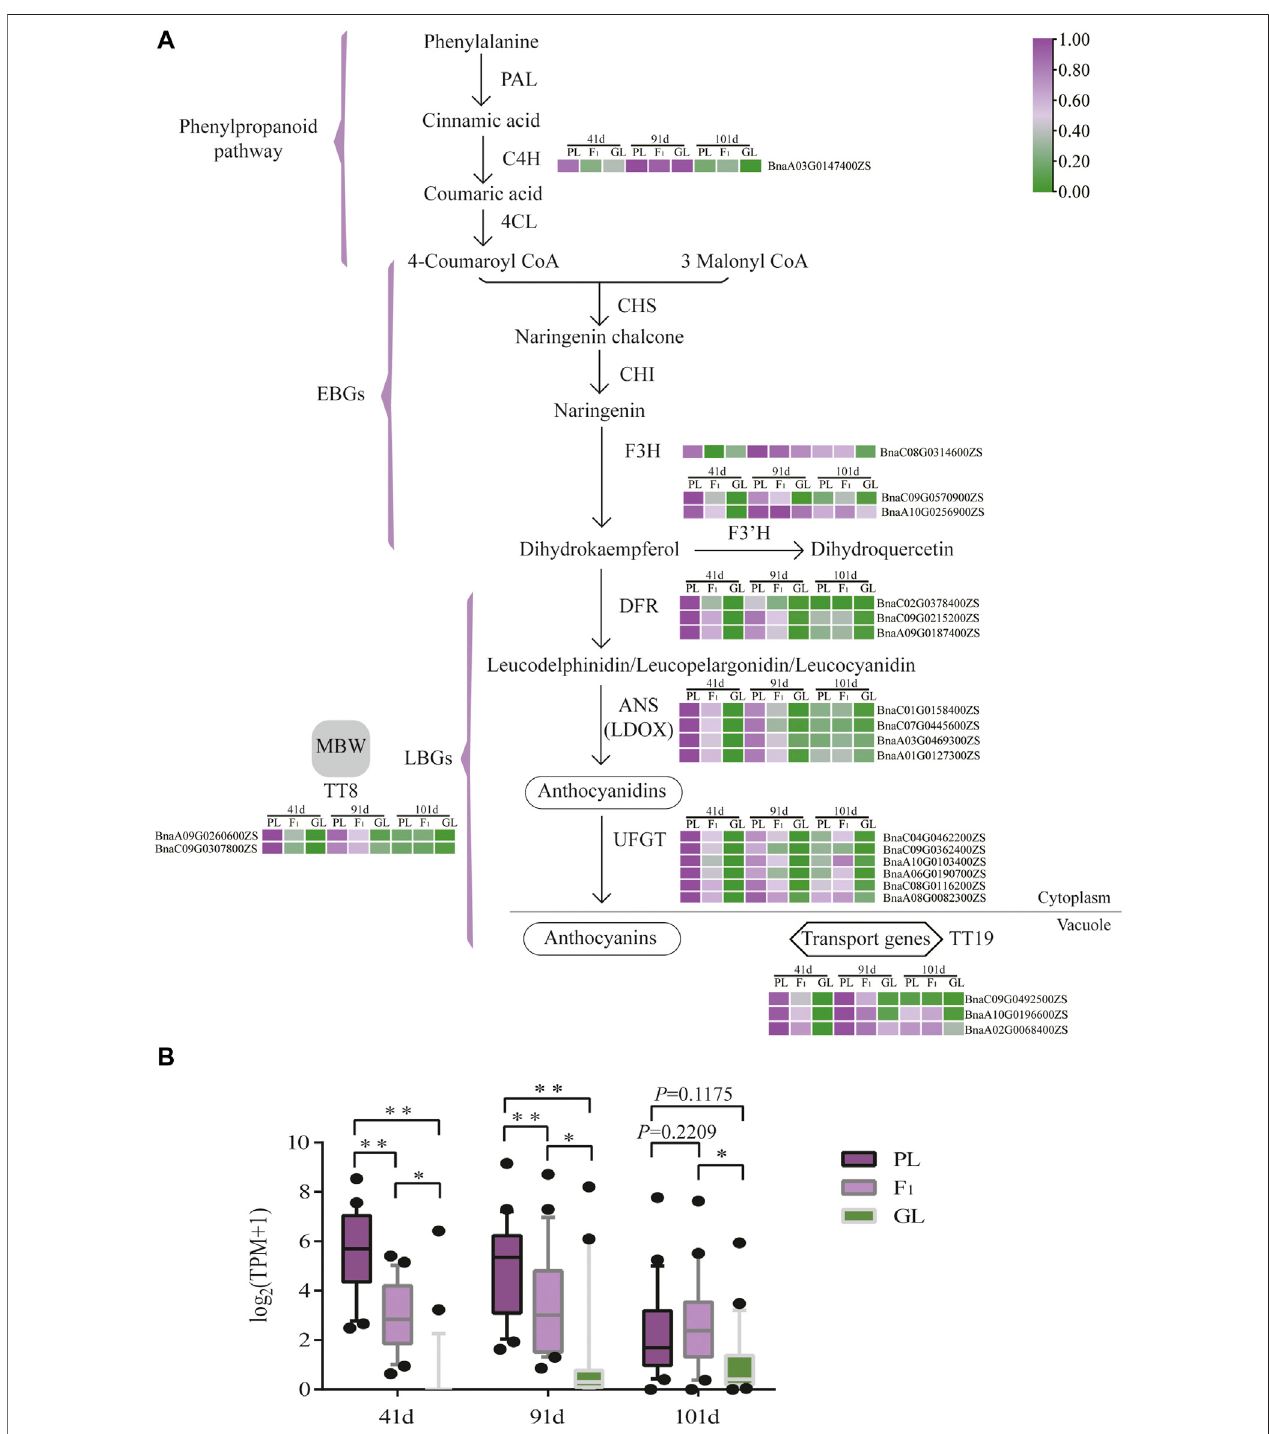
FIGURE 4 | Anthocyanin biosynthetic pathway and expression patterns of ABGs in B. napus. (A) The expression level of ABGs which are differentially expressed between PL and GL is shown in the pathway. Purple and green colors are used to represent high to low expression levels, respectively. The color scale corresponds to the mean-centered log2-transformed average TPM values from three replicates. (B) The overview of ABG expression, which was differentially expressed at different stages. Asterisks indicate statistical differences between each other (two-tailed Student ’ s t -test, ** indicates p < 0.01; * indicates p < 0.05).